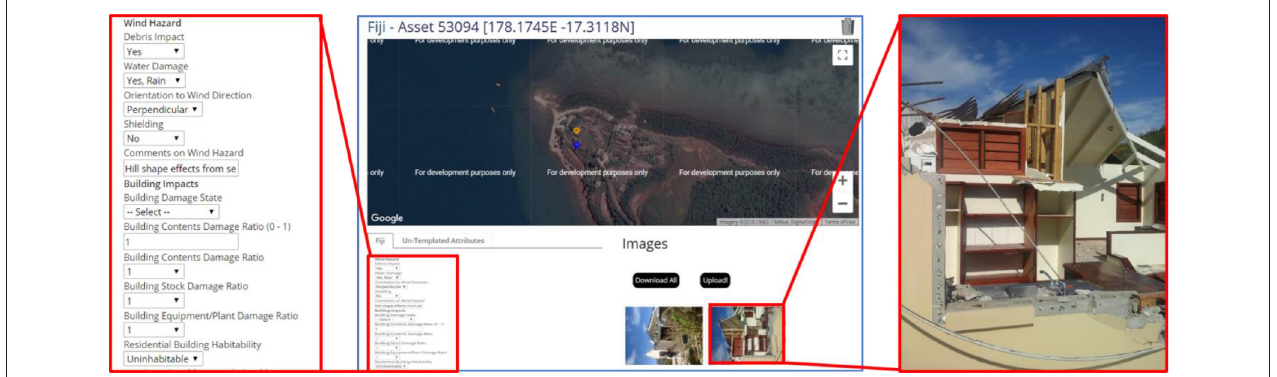
FIGURE 7 | Screenshot of hazard and damaged information during TC Winston in